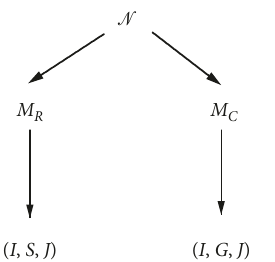
Figure 1: The diagram for the semigroup N